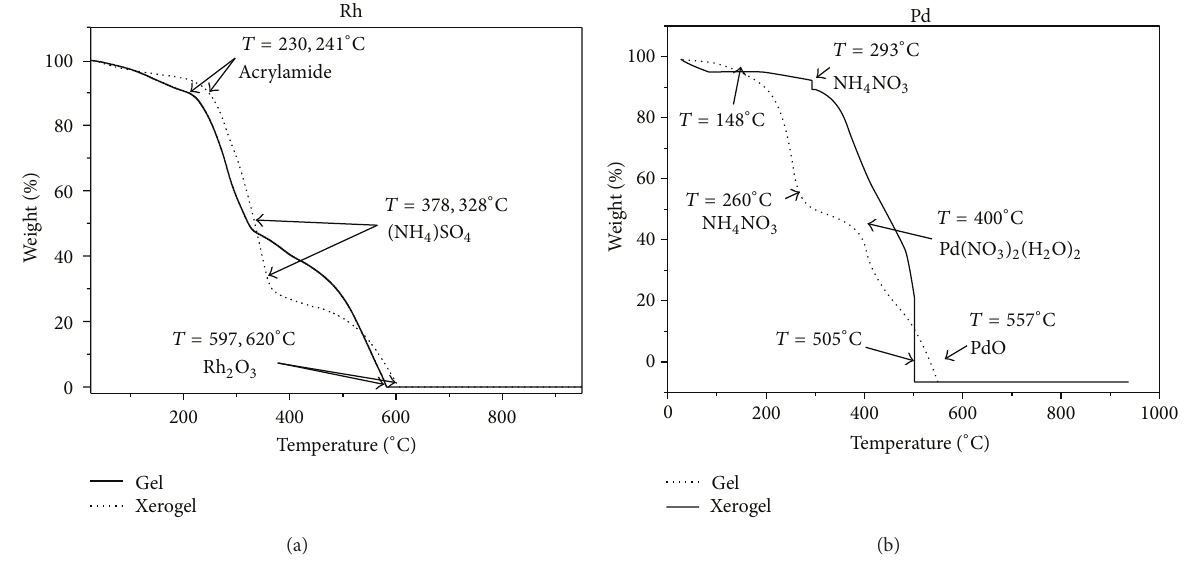
Figure 2: TGA curves from gel and xerogel for (a) rhodium and (b) palladium.